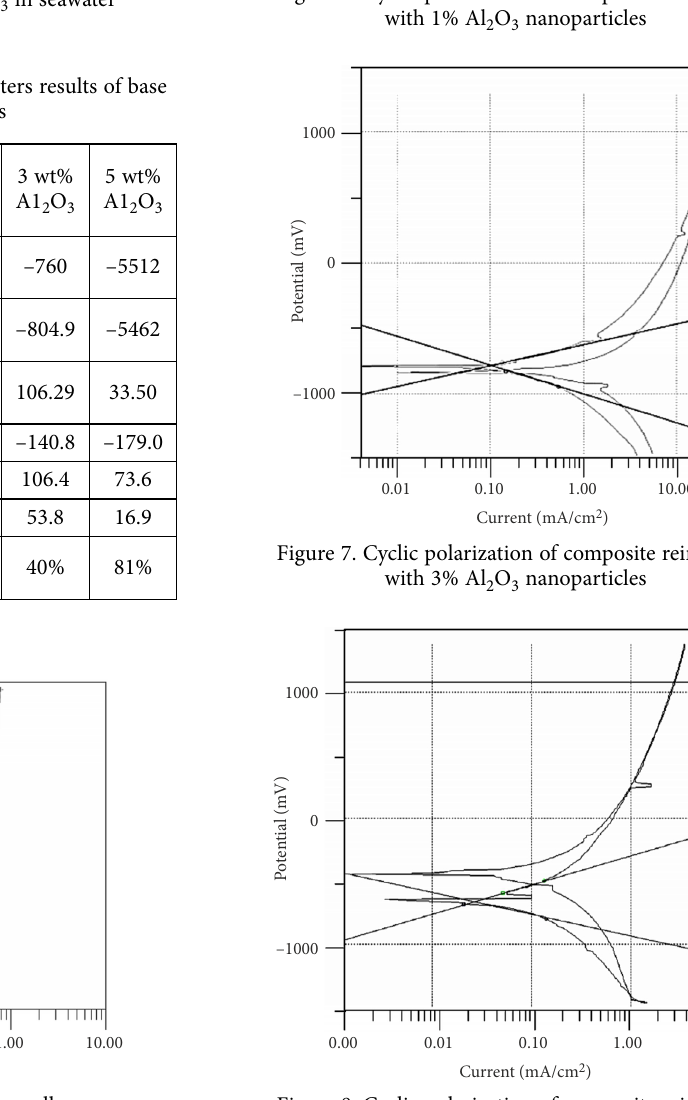
Figure 6. Cyclic polarization of composite reinforced